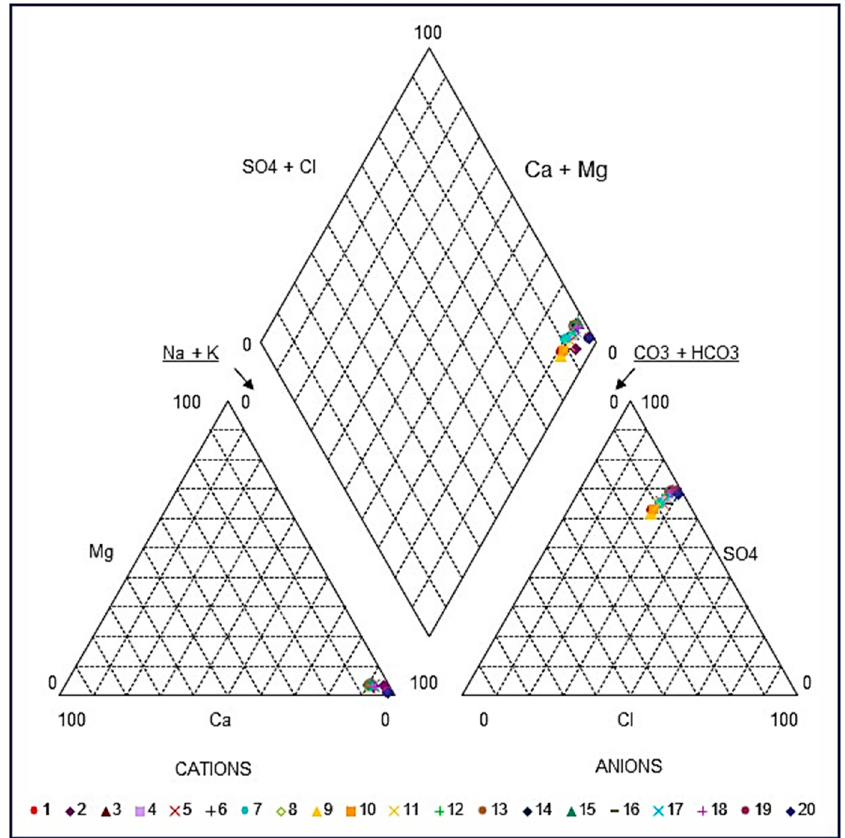
Figure 5. ( a ) Schöeller-Berkaloff diagram highlighting the geochemical behavior of water in the Sochagota Lake. Red marks indicate healthy recommended values [25.] ( b ) Salinity Diagram for Classification of Irrigation Waters for Sochagota Lake. Samples 19 and 20 are omitted from the plot (19-SAR: 66; 20-SAR: 70). Legend for water quality in this plot is: c1-s11: Very Good; c1-s2, c2-s1, c2-s2: Good; c1-s3, c2-s3, c3-s1: Medium; c1-s4, c2-s4, c4-s1, c3-s2: Bad; c3-s3, c3-s4, c4-s3, c4-s4: Very Bad.